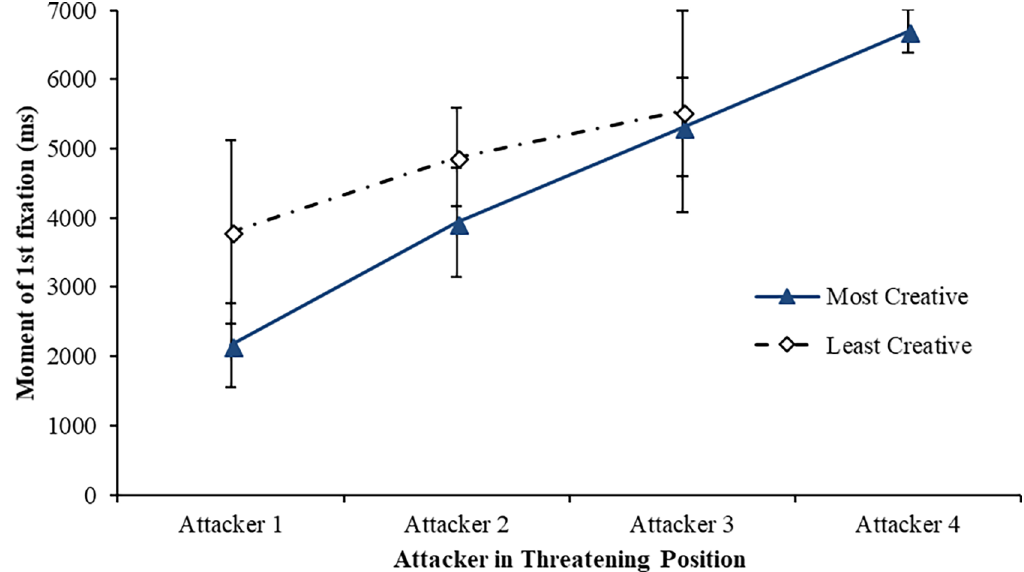
Fig 2. Mean (SD) moment of 1 st fixation in the attack on attackers in threatening position across